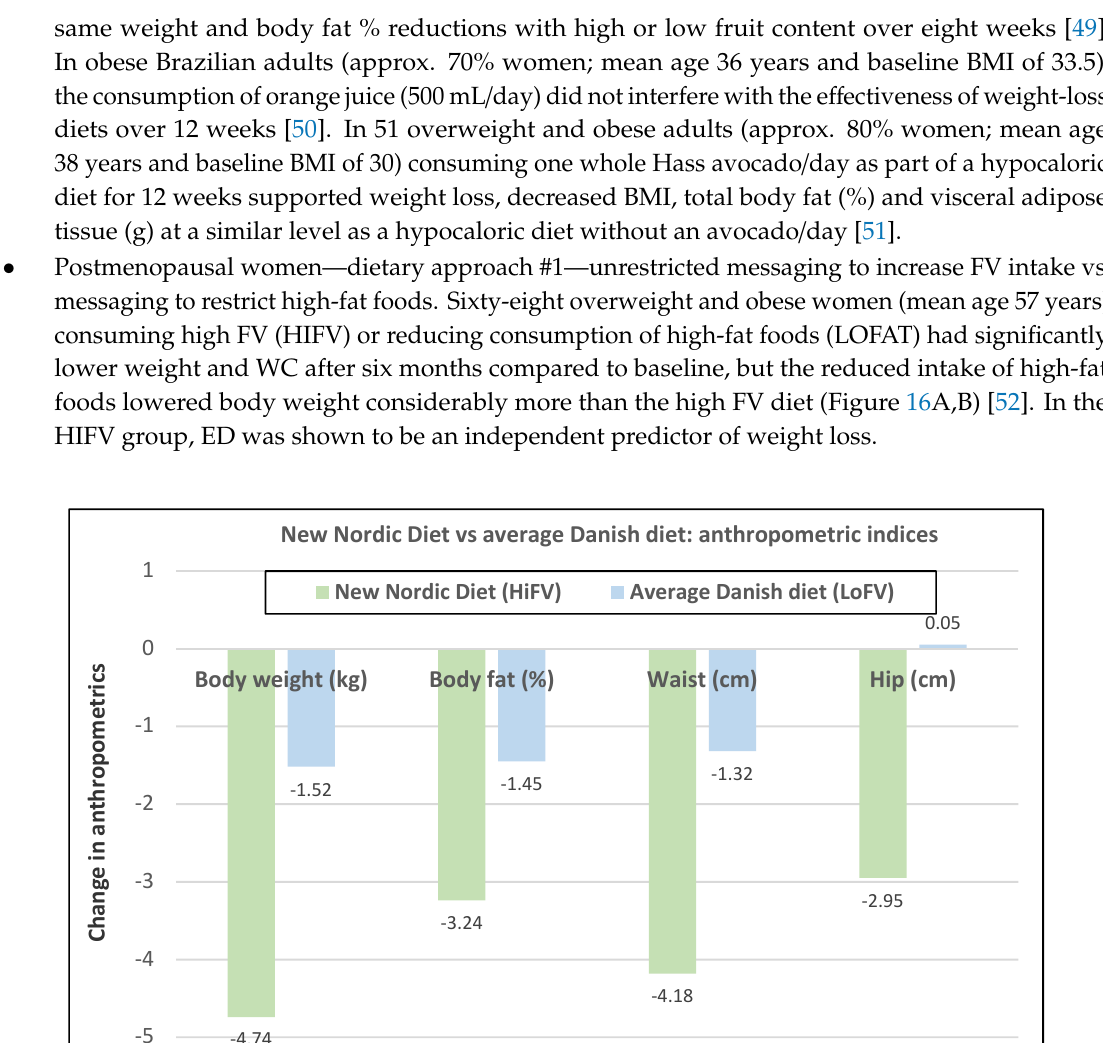
Figure 9. Ad libitum New Nordic Diet (high in healthy fruits and vegetables) vs. average Danish diet (low in fruits and vegetables) in 147 centrally obese adults (71% women; mean age 42 years) who completed the 26-week trial ( p < 0.001 for all) [40]. Nutrients 2020 , 12 , x FOR PEER REVIEW Premenopausal women—dietary approach # 2—adding low ED fruit vs. high ED cookies to the usual diet. Women consuming apples or pears had significant weight loss compared to the modest weight gain of women consuming oatmeal cookies over ten weeks (Figure 10) [41].